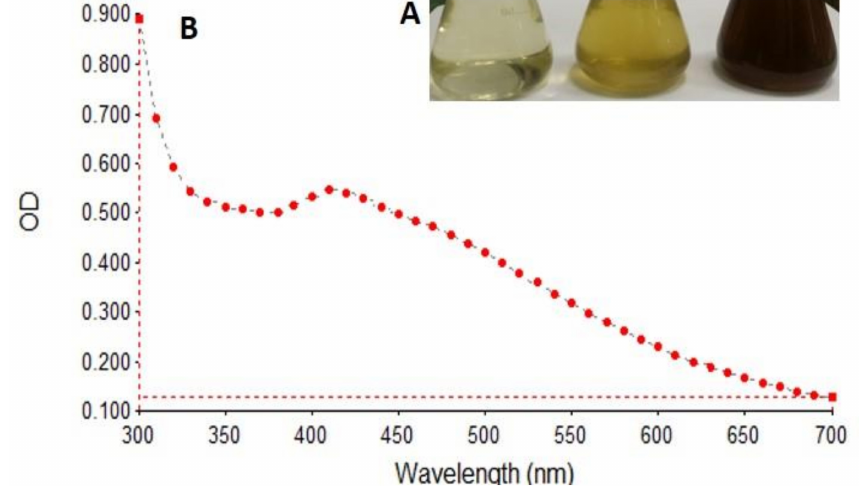
Figure 1. Biosynthesis of silver nanoparticles. Color change reaction in the mixture ( S. molle extract + silver nitrate) from yellow to brown ( A ). UV-vis spectroscopy scanning at the wavelength of 300–700 nm exhibits intense SPR peak at 412 nm ( B